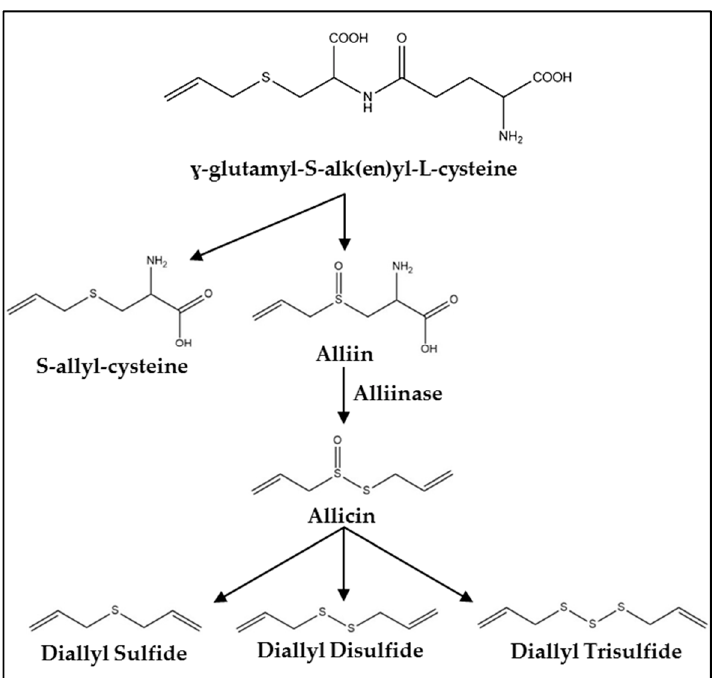
Figure 1. Synthesis pathway of organosulfur compounds (OSCs) in Allium vegetables.